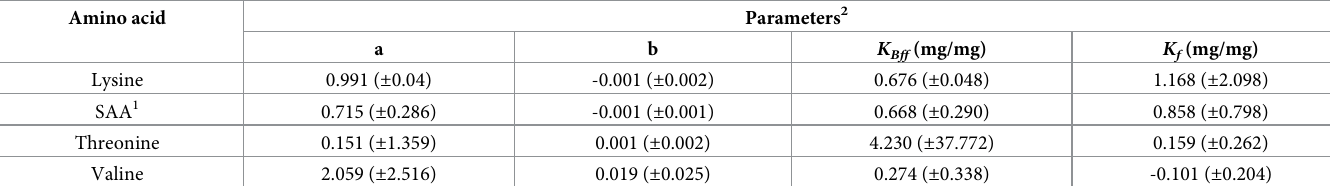
for other amino acids according to equation Z = a + b � ( age − 8) for lysine and Z = a + b � ( age − 14) for sulfur amino acids, threonine, and valine; b is the change in amino acid intake directed for feather-free body deposition ( Z ) due to a change in age; K efficiency of feather amino acid